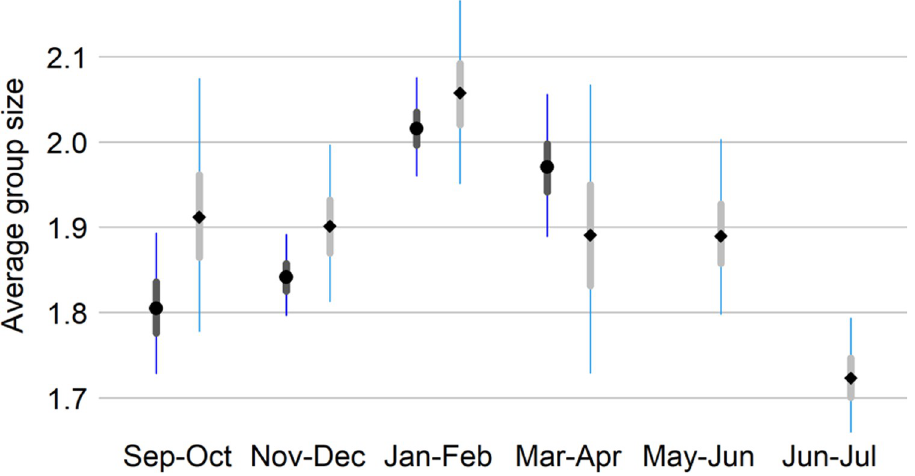
Fig 4. Marbled murrelet density by strata within survey season. Estimated ( ± 95% Crl) marbled murrelet density for each year and 2-month survey window combination in Strata 2,3,4, and 5.